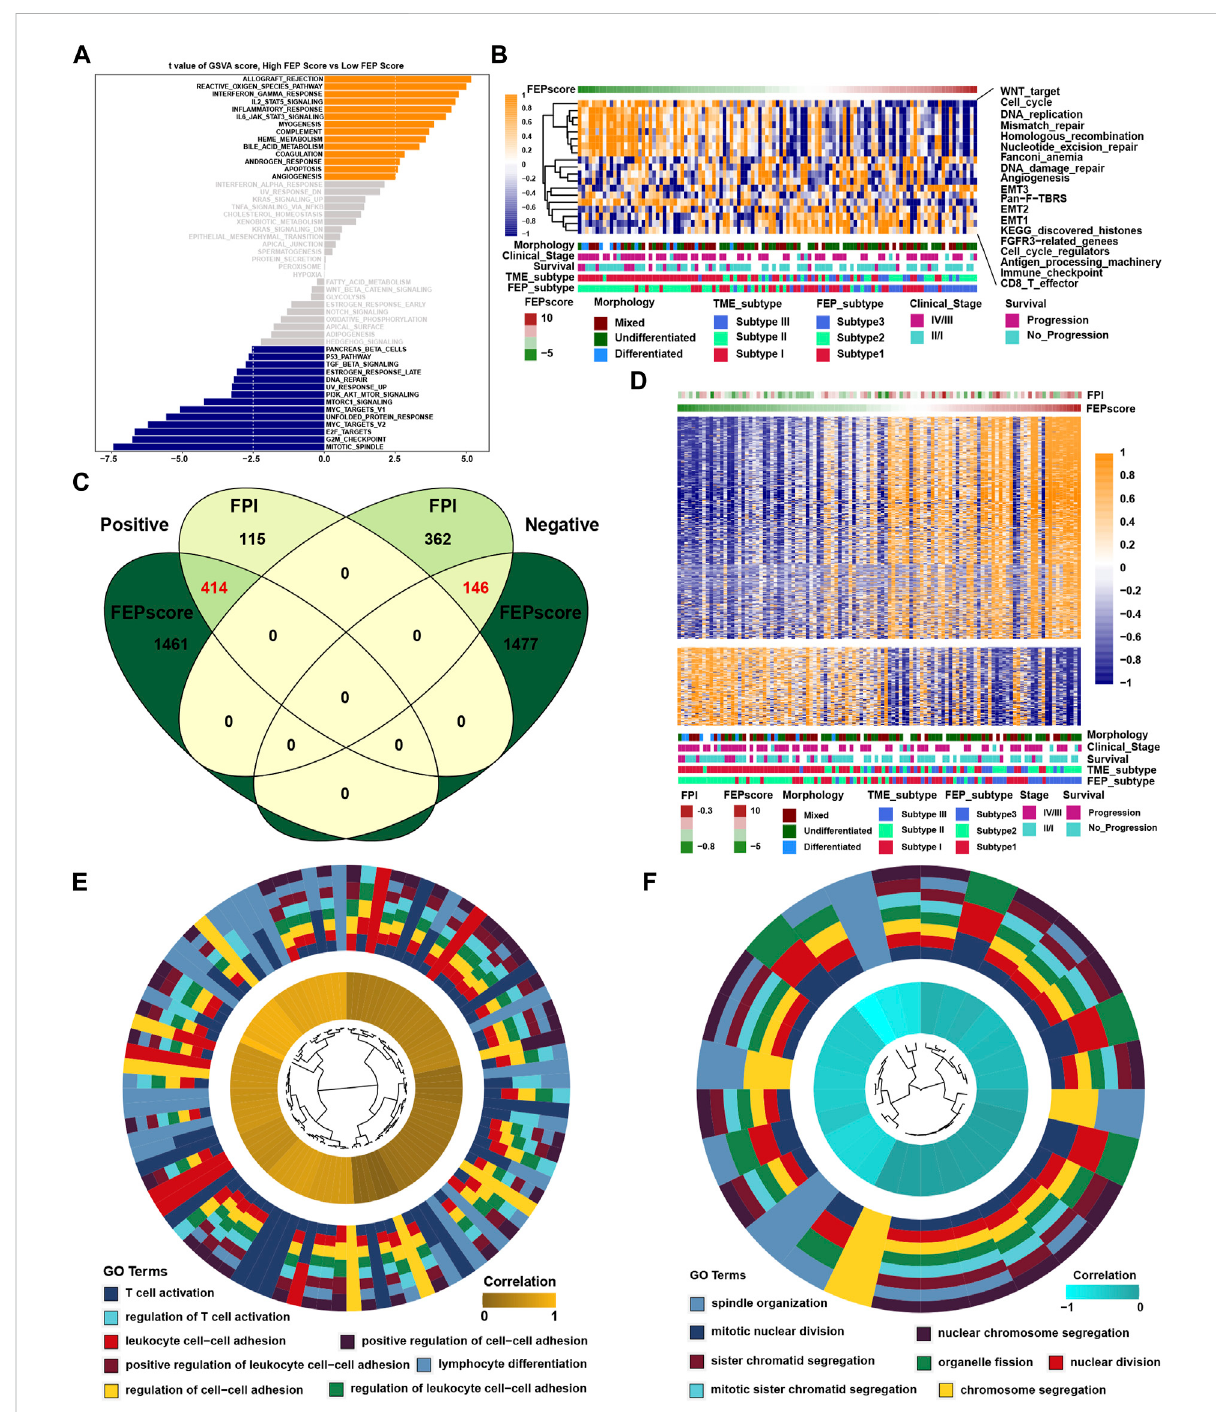
FIGURE 4 CharacteristicsandbiologicalfunctionofFEPscoreinNPC. (A) GSVAscoreforpathwaysinlowandhighFEPscoregroups.Theorangeandblue columns represented pathways enriched in high and low FEP score group, respectively. (B) Correlations between FEP score and known gene signatures in NPC using Spearman analysis. Positive and negative correlations were marked with orange and blue, respectively. (C) Venn plot of candidate ferroptosis related genes and the red fonts represented the intersection genes correlated with FPI and FEP score simultaneously. (D) Heatmapofcandidateferroptosisrelatedgenesamongferroptosissubtypes.Morphology,clinicalstage,survival,andTMEsubtypeswereadoptedas annotations. (E – F) GO analysis of candidate ferroptosis genes positively or negatively correlated with FPI and FEP